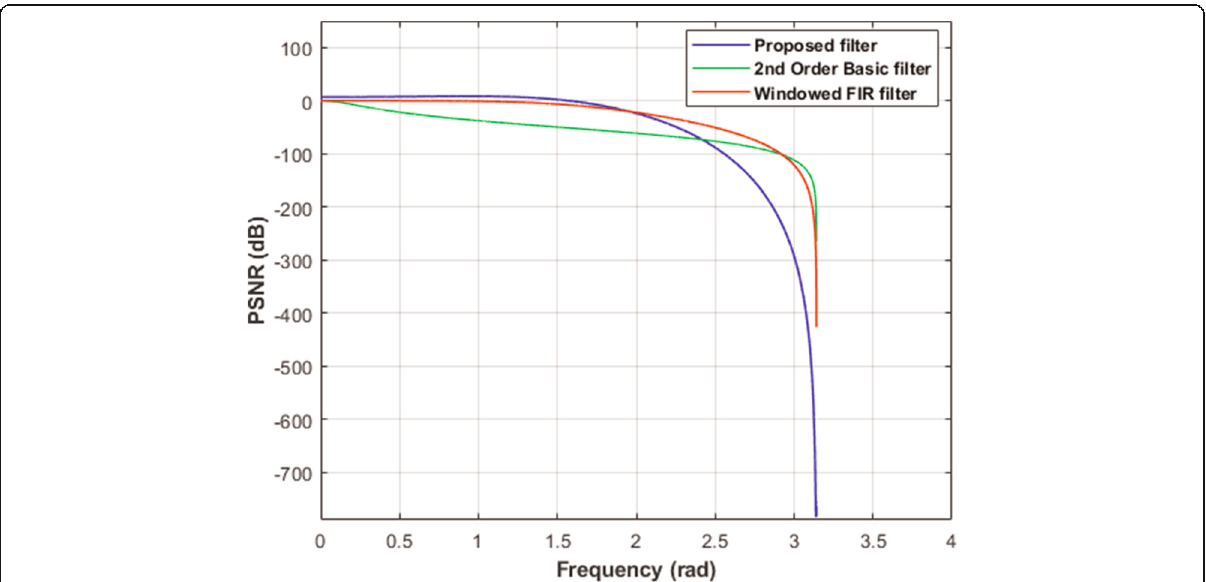
Fig. 7 Frequency response absolute values (in decibels) for the proposed filter design, compared to a digitized continuous-time low-pass filter. The relative amplitude is varied from zero to unity